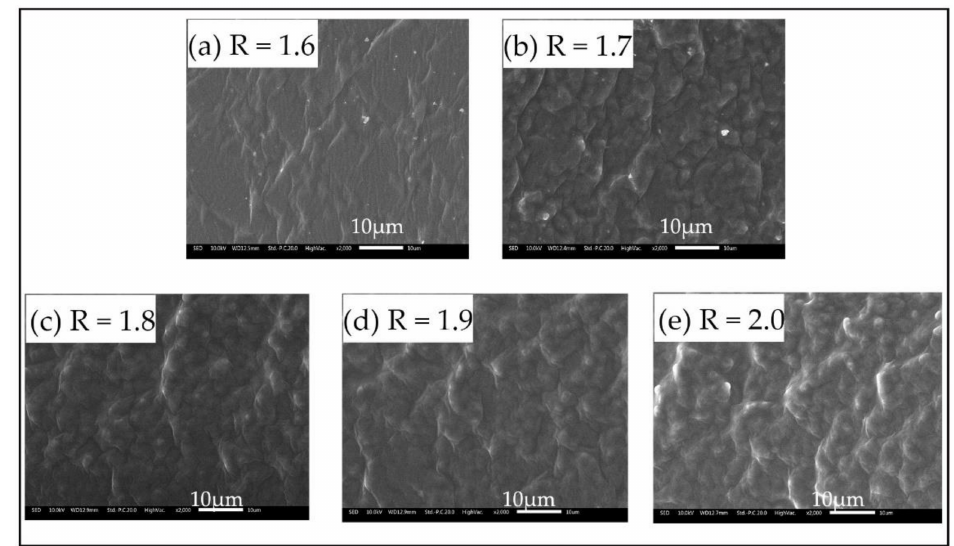
Figure 7. Scanning electron microscope cross-sections of SPU films with different R values. ( a ) R =1.6, ( b ) R = 1.7, ( c ) R = 1.8, ( d ) R = 1.9, ( e ) R = 2.0.